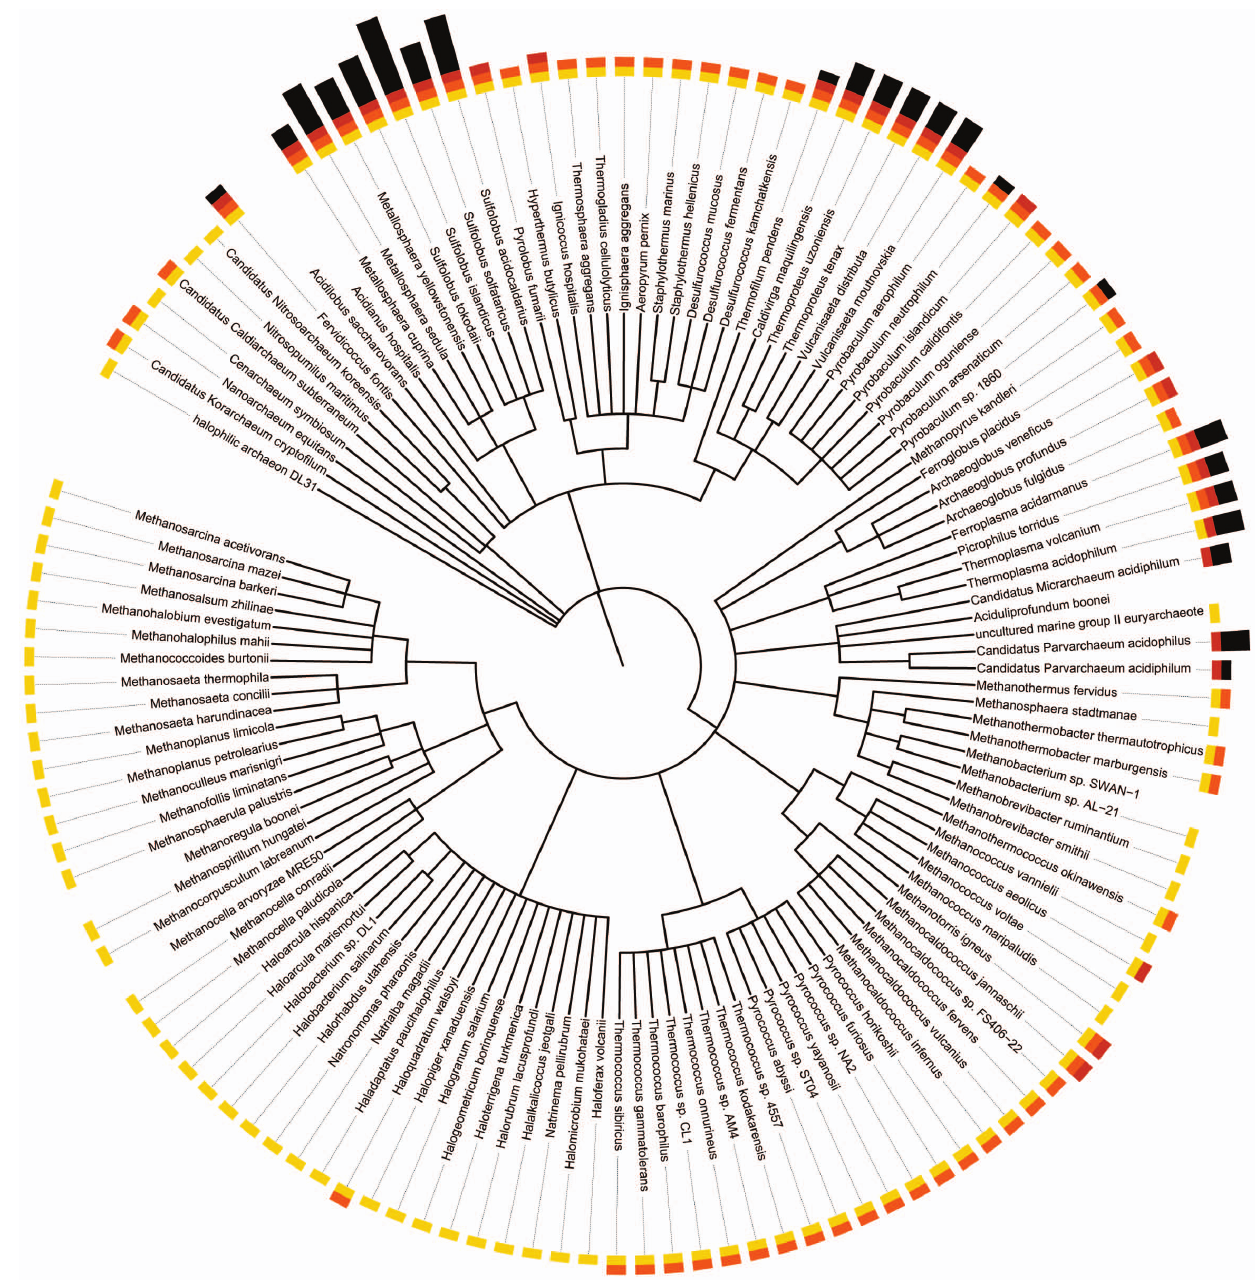
Figure 1. Distribution of thermopsin homologues amongst archaea with completely sequenced genomes. The phylogenetic tree is based on the classification from the NCBI Taxonomy database. Tips are annotated with coloured bricks as follows: yellow, completely sequenced genome; orange, hyperthermophilic; red, acidiophilic; black, presence of a thermopsin homologue. The number of black bricks indicates the number of thermopsin